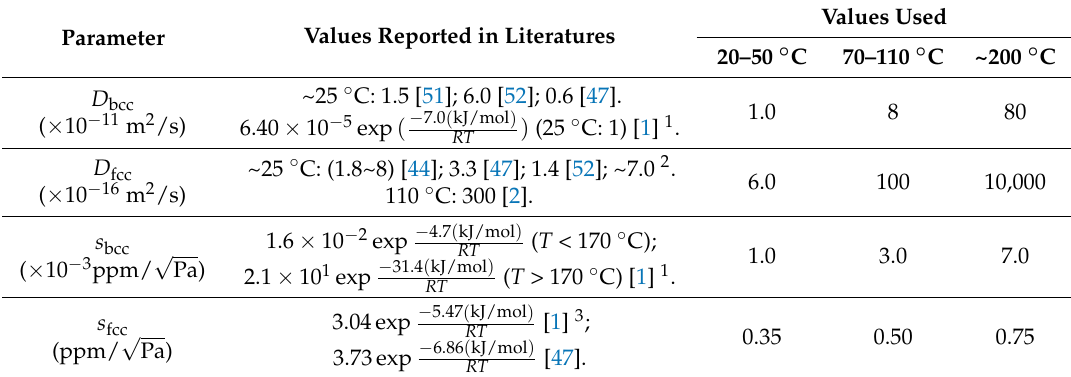
Table 2. Hydrogen transport parameters used for the theoretical modeling and FE simulations. Parameter Values Reported in Literatures